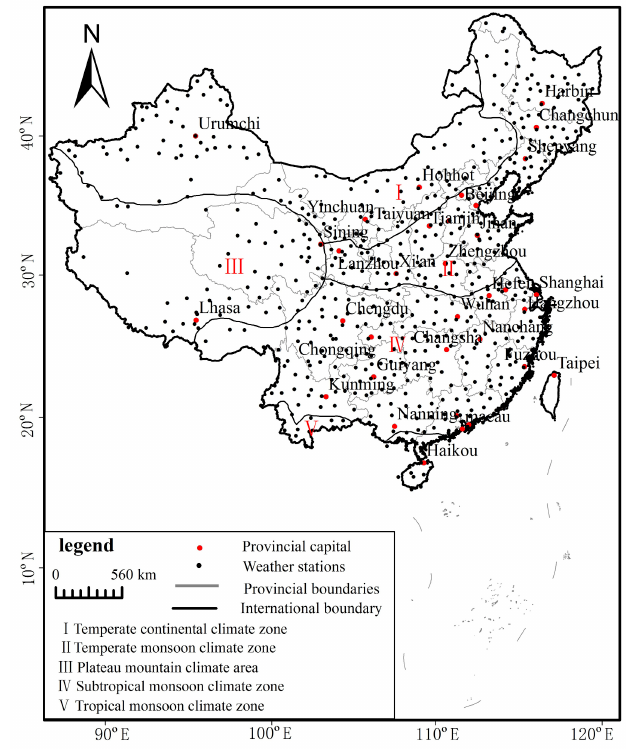
Figure 2 . Distribution of stations in the study area. Figure 2. Distribution of stations in the study